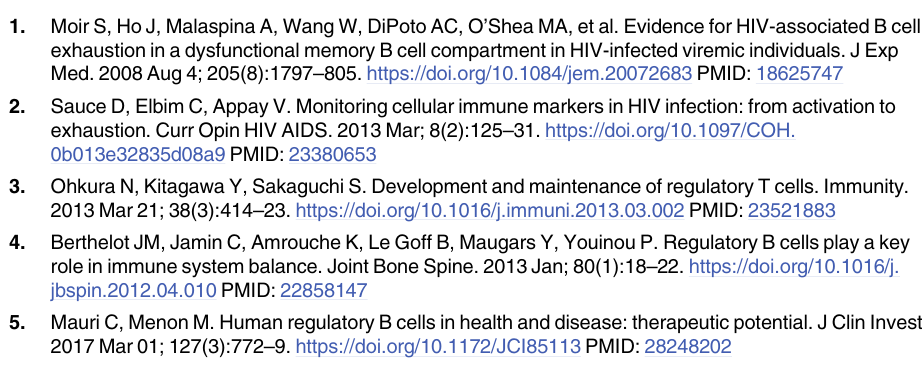
S2 Table. Cellular populations followed in this study. Description of the T and B-cell subsets followed in this study and the gating